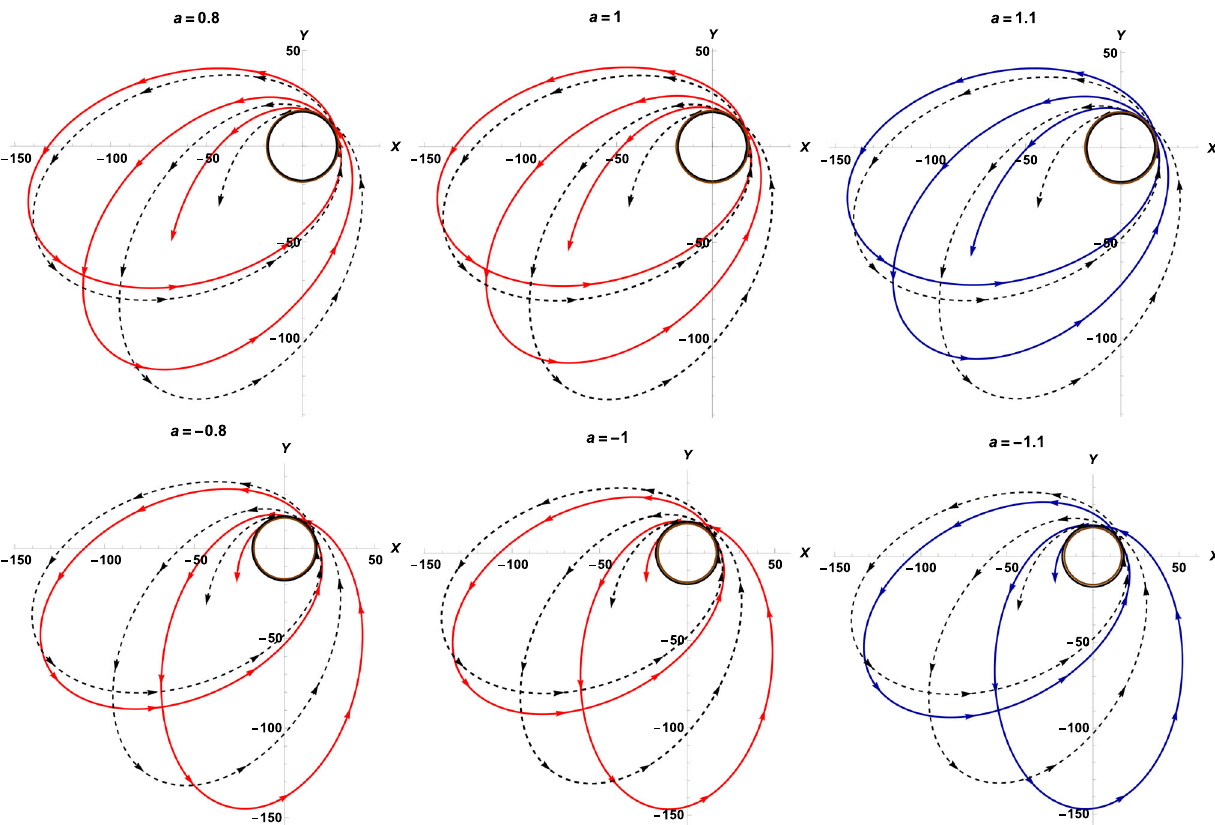
a = 1 . 1 , r min = 18 . 86, and a = − 1 . 1 , r min = 16 . 64 (third column). Black dotted lines indicate particle’s orbits in the Schwarzschild space- time (for a=0, r min = 17 . 91). Brown circles represent the minimum approach of the particle towards the center. Here, we have considered M = 1, L = 6 and total energy is E = − 0 . 006